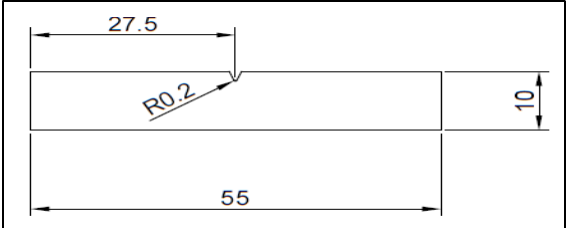
Fig. 2. Standard Impact Test Specimen in mm (ASTM E23-04).